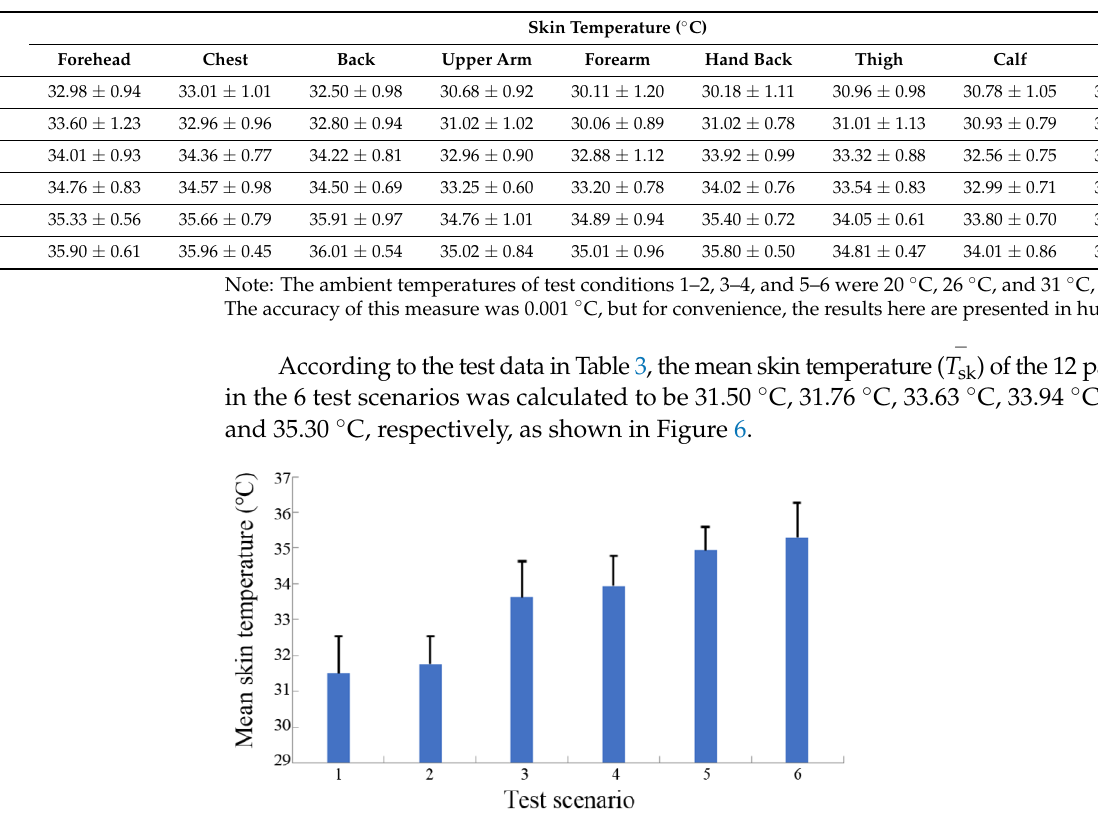
Table 3. Local skin temperature under different test scenarios.